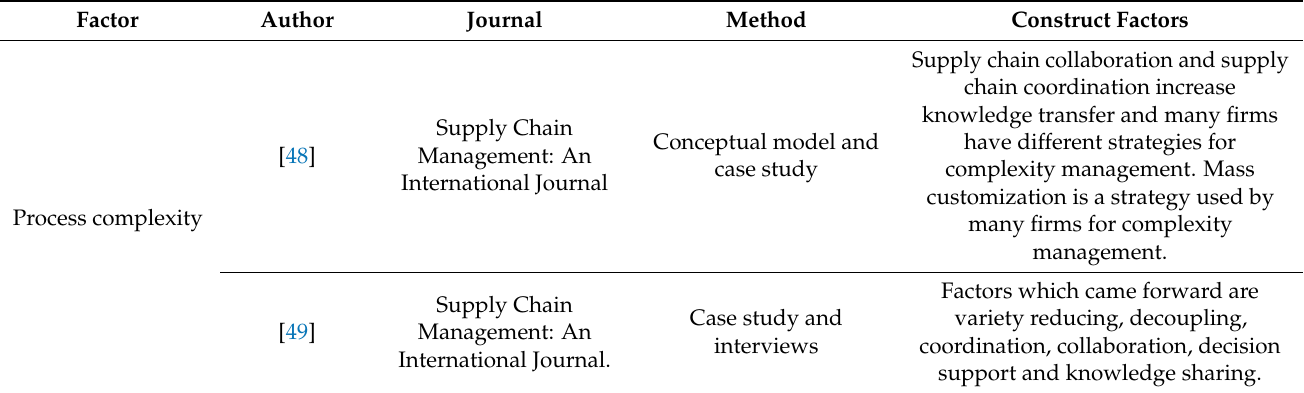
Table 4. Construct factors collected for process complexity (author’s